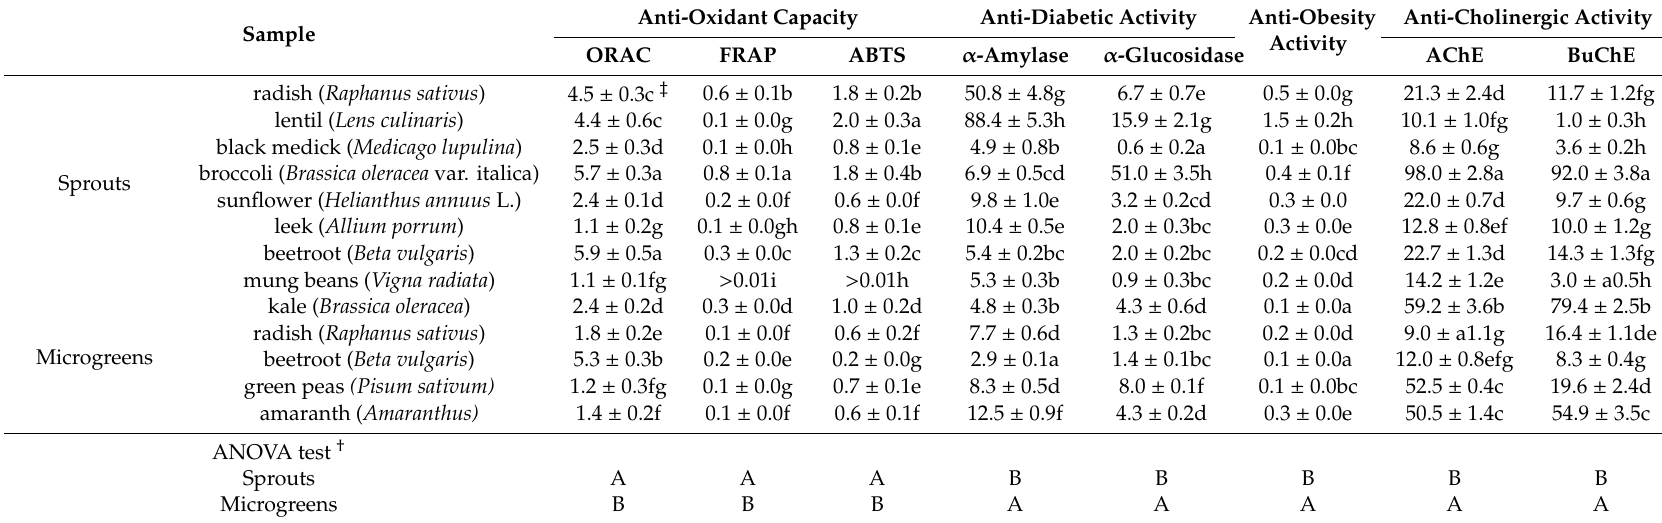
Table 4. In vitro biological activity as anti-oxidant capacity (ORAC, FRAP, ABTS) and anti-diabetic, anti-obesity, and anti-cholinergic activity of sprouts and microgreens.